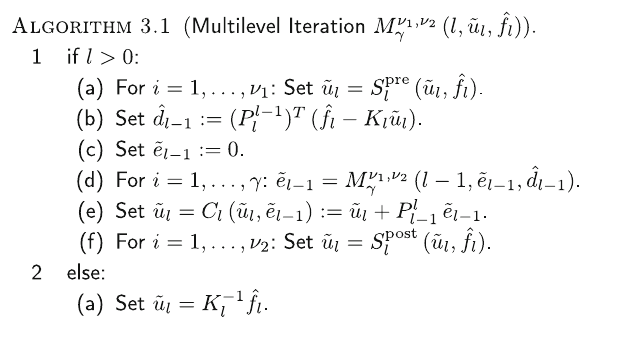
for a small (top) and a HOST ,J − 1